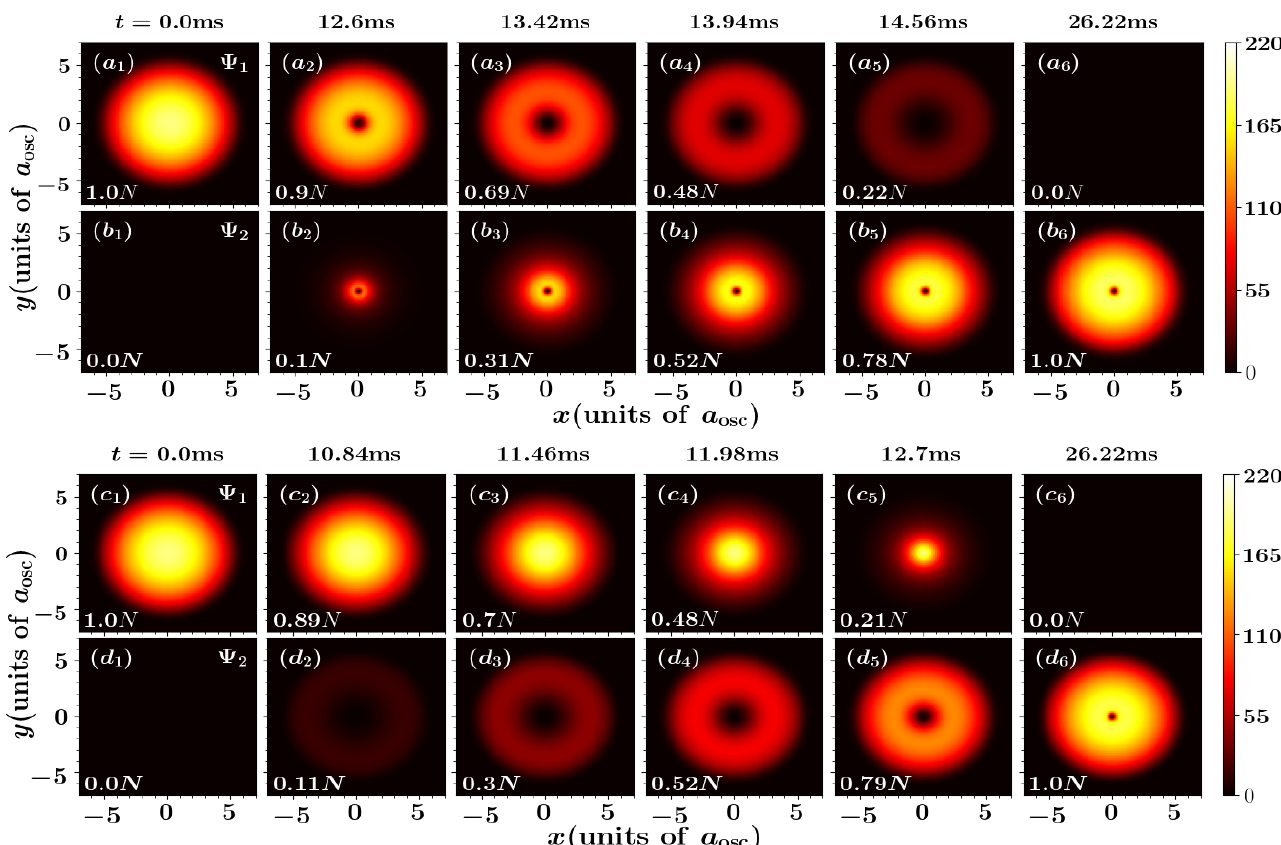
Figure 2. (Color online) Shows the time evolution of density profiles of the condensates of ( a 1 – a 6 ), ( c 1 – c 6 ) atoms in | 1 (cid:105) and ( b 1 – b 6 ), ( d 1 – d 6 ) those in | 2 (cid:105) , when − 1 unit [( b 1 – b 6 )] and + 1 [( d 1 – d 6 )] unit vortex is created in the condensate Ψ 2 . In the course of time, the condensate Ψ 2 gets populated. The fraction of atoms in the condensate with respect to total number of atoms N = 10 4 , is mentioned at the bottom left corner of each figure. Atoms are kick-started to be transferred from the condensate Ψ 1 to the condensate Ψ 2 in the central region of the trap for − 1 unit vortex transfer, but in the peripheral region of the trap for + 1 unit vortex transfer. Almost 100% atoms get transferred to state | 2 (cid:105) for both the